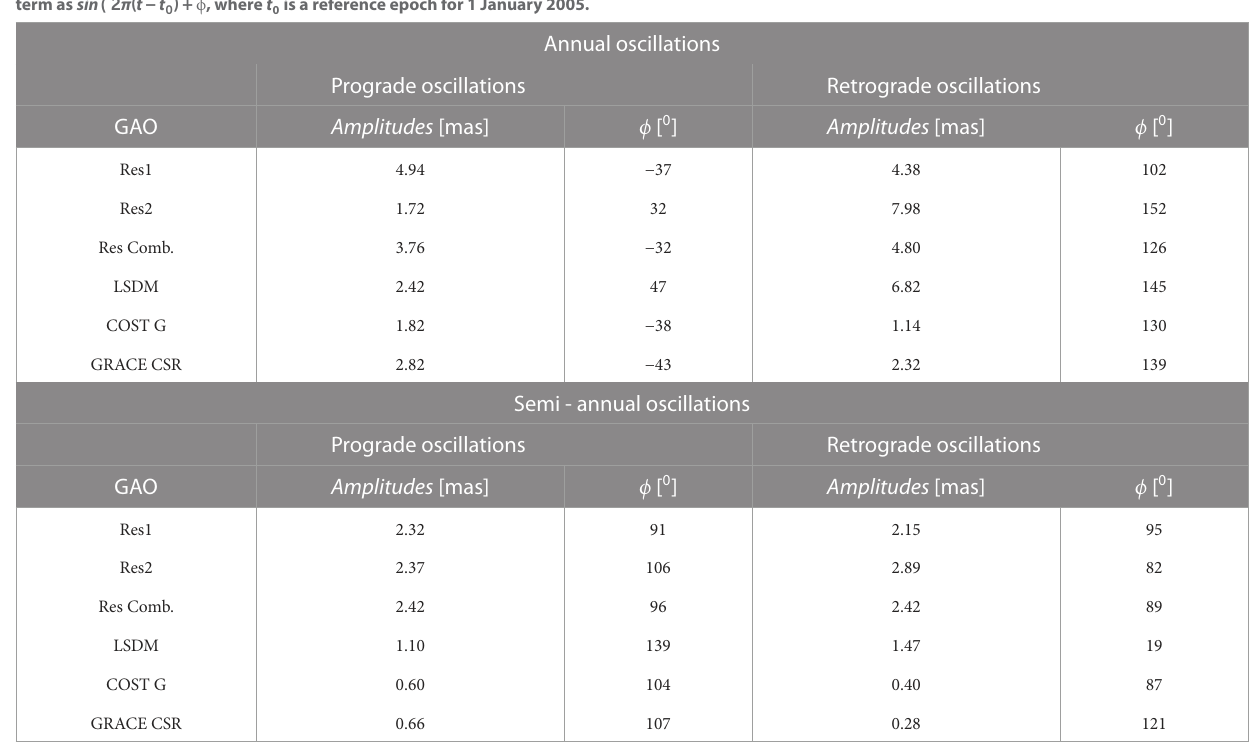
TABLE3 Amplitudesandphases ( ϕ ) ofprogradeandretrogradebothannualandsemiannualoscillationsofgeodeticresiduals(Res1,Res2,andResComb.),and ofhydrologicalexcitationscomputedfromLSDMmodelandfromGRACEdata(COST-GandCSRsolutions).Phase ϕ